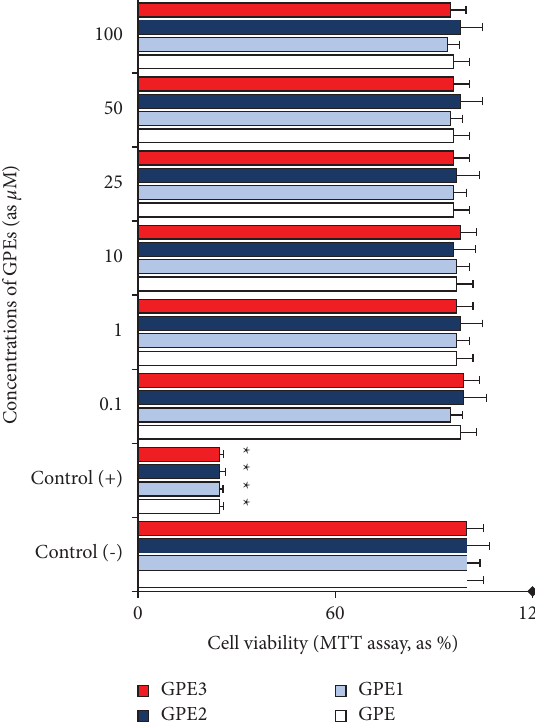
Figure 3: Extracellular LDH levels in cultured PHWB cells treated with diferent concentrations of GPEs p < 0 . 05 ∗ .